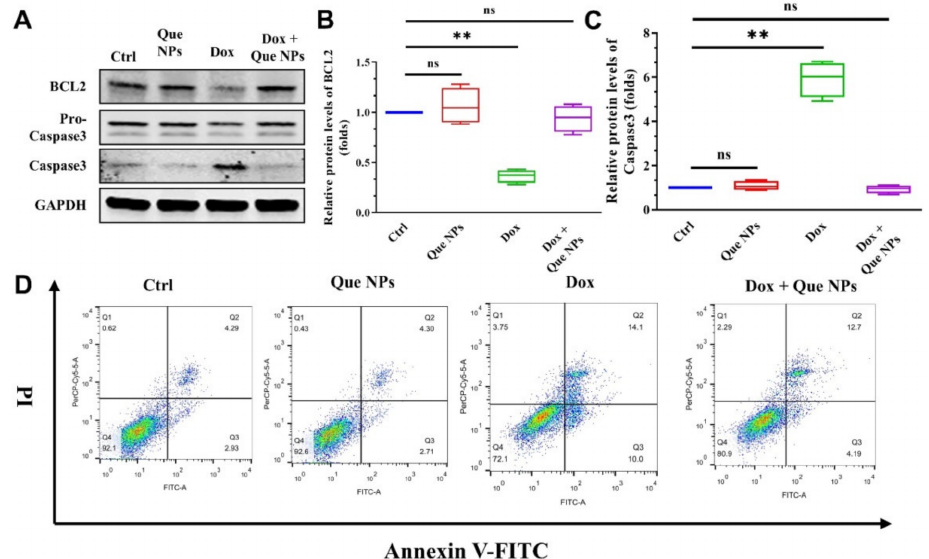
Figure 3. Evaluation of cellular apoptosis: ( A ) representative pictures of western blotting results; ( B , C ) statistical analysis of the expression changes of BCL2 ( B ) and Caspase3 ( C ) described in ( A ); and ( D ) flow cytometry analysis of the cellular apoptosis. **, p < 0.01; ns, no